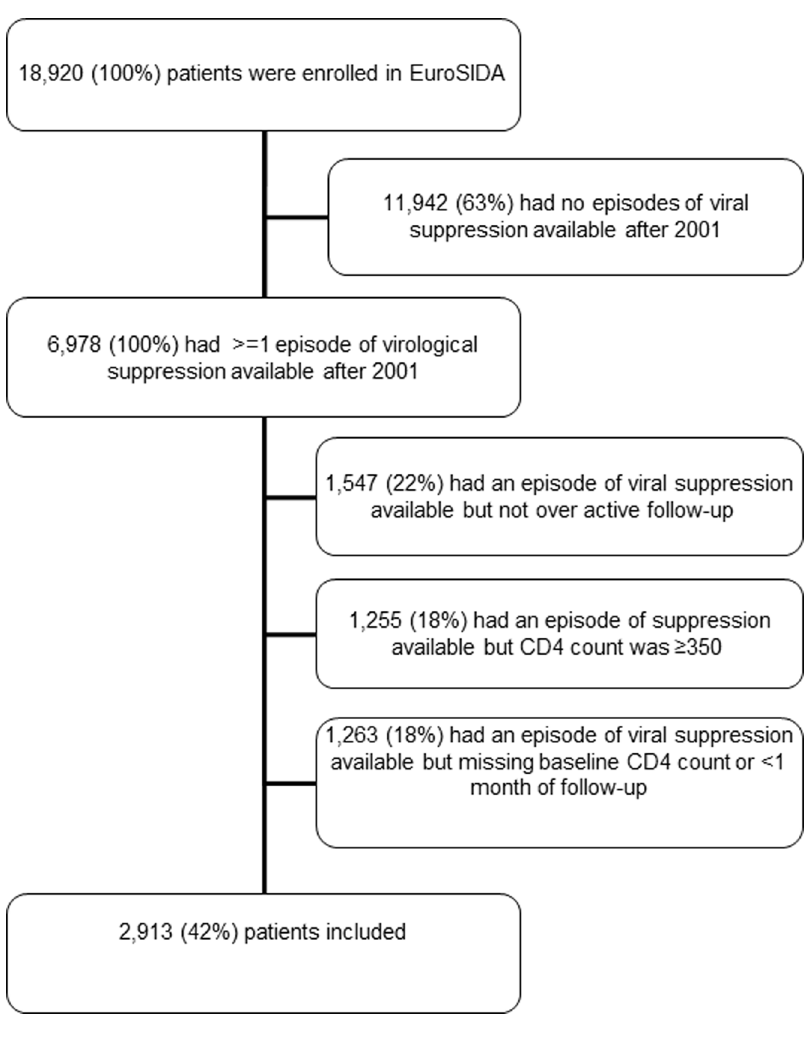
Figure 1. Flow chart showing selection of patients enrolled in EuroSIDA for the analysis.